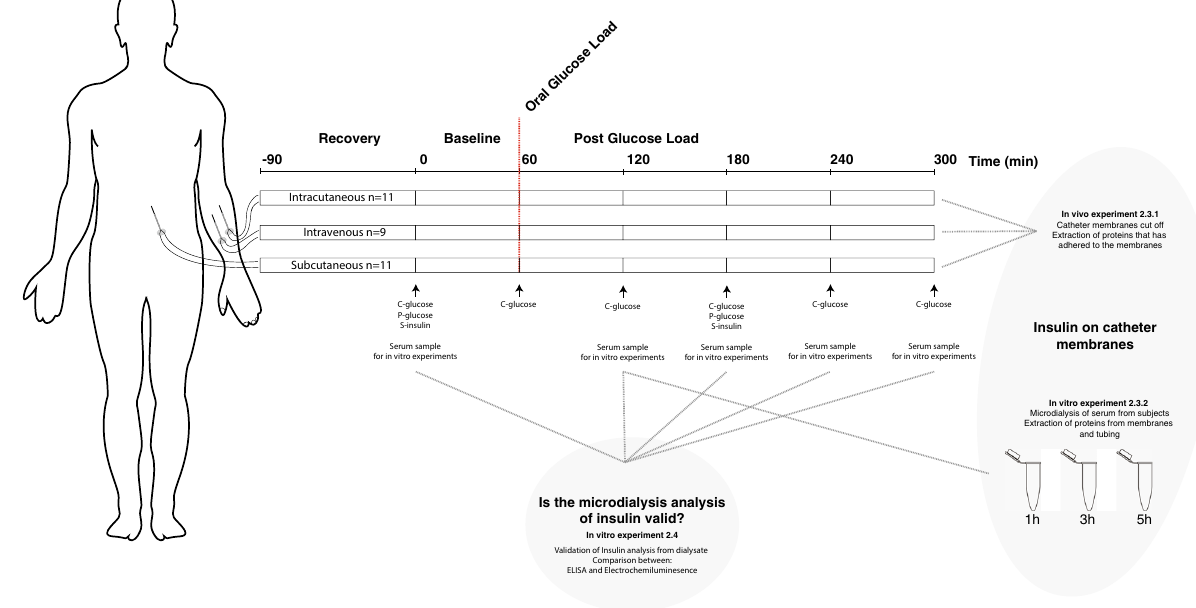
Figure 1. Experimental protocol and setup for in vivo and in vitro experiment in healthy subjects (N = 12). C ‐ glucose = capillary glucose; P ‐ glucose = plasma glucose; S ‐ insulin = serum